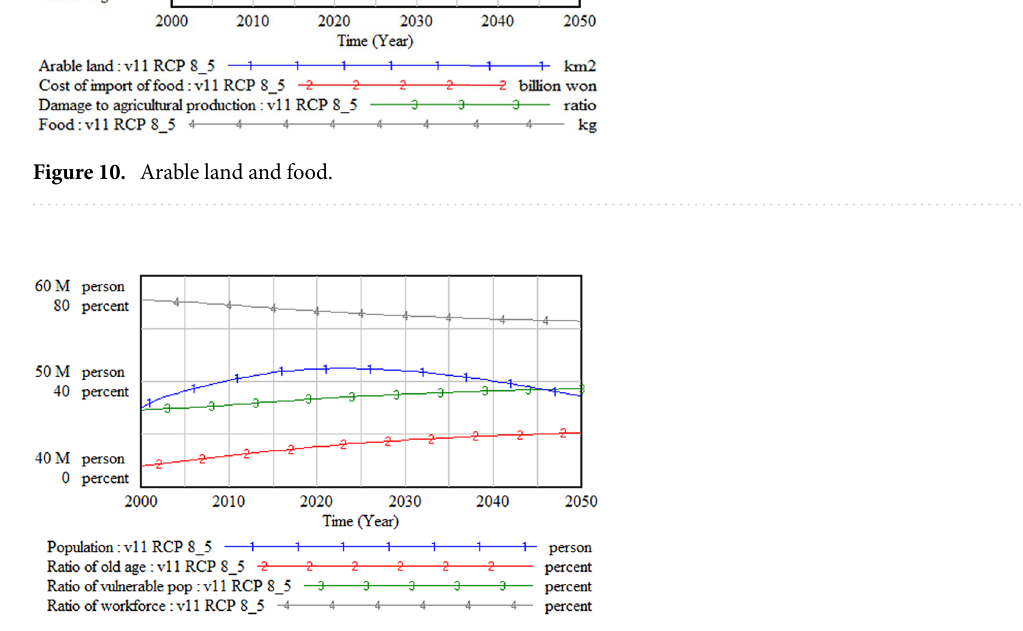
Figure 11. Population and